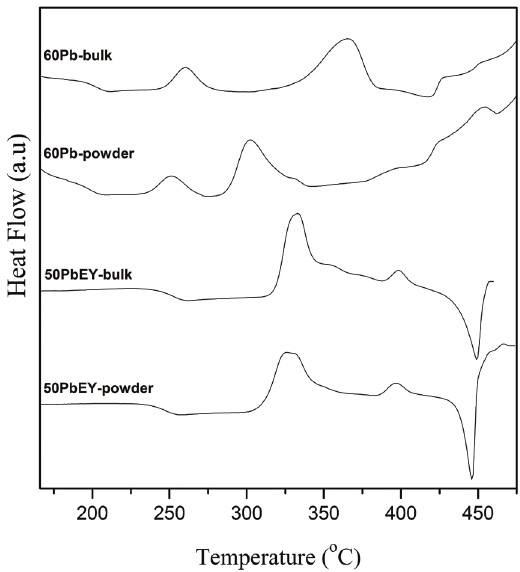
Figure 6. DSC curves of sample 50PbEY and 60Pb in the bulk and powder